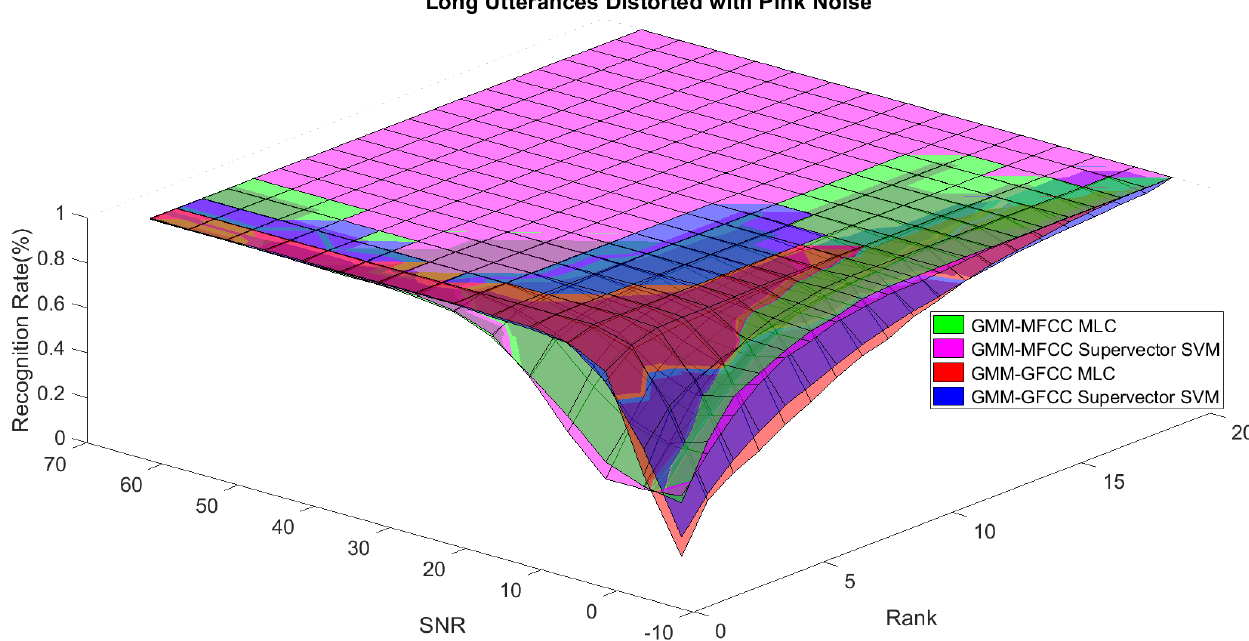
Figure 15. The 3D surface of the recognition rates for the base classifiers on long utterances distorted with pink noise.